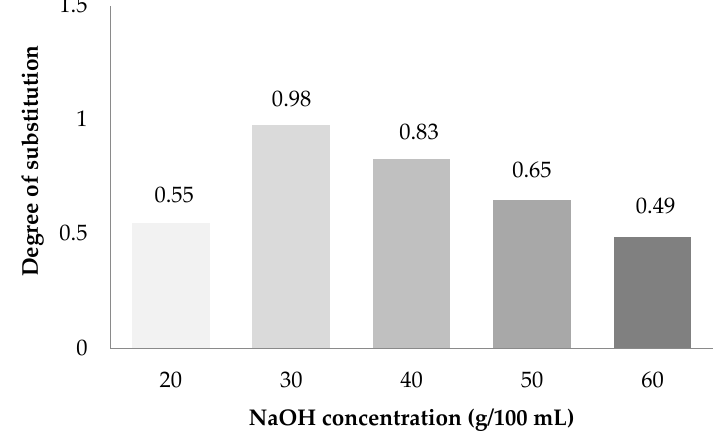
Figure 1. Percent yield of carboxymethyl cellulose from asparagus stalk end (CMC as ) .